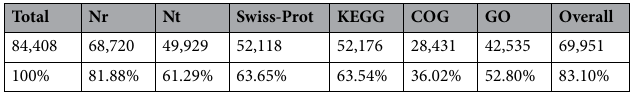
Table 3. The annotation of all unigenes in Sophora flavescens.